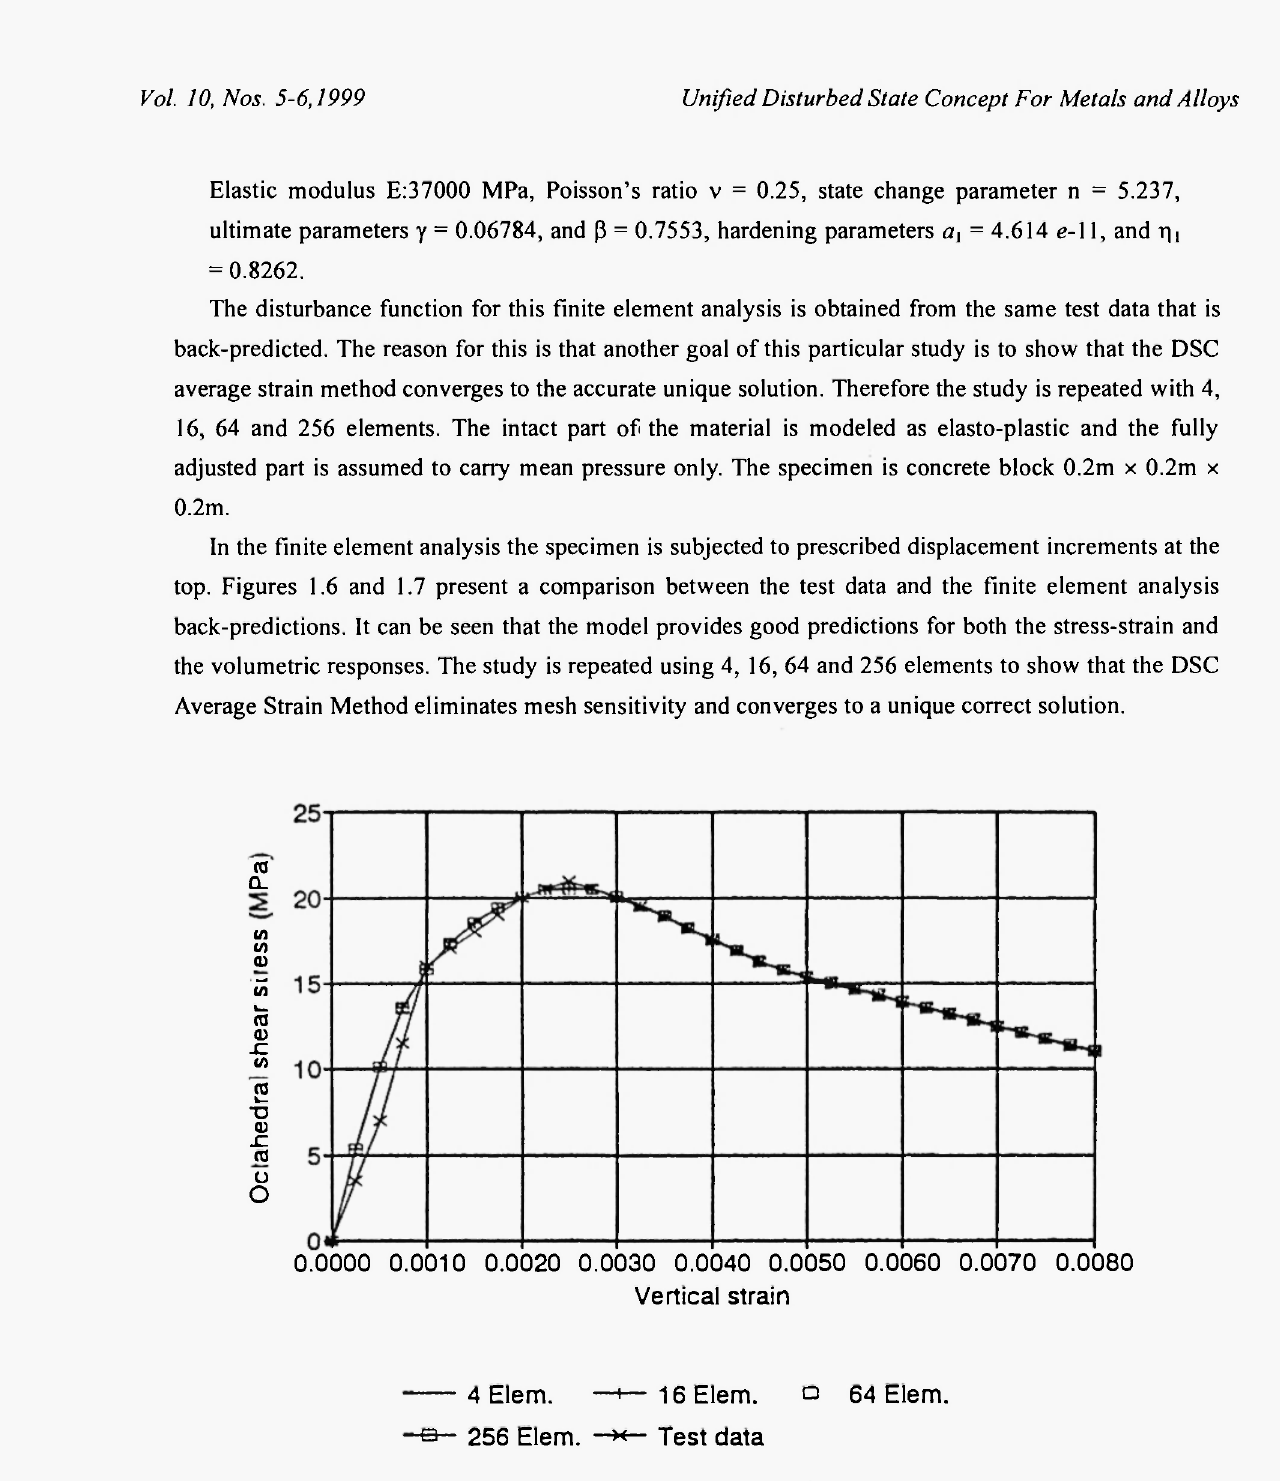
Fig. 1 .6: Comparison with test data, x oct vs. ε Υ